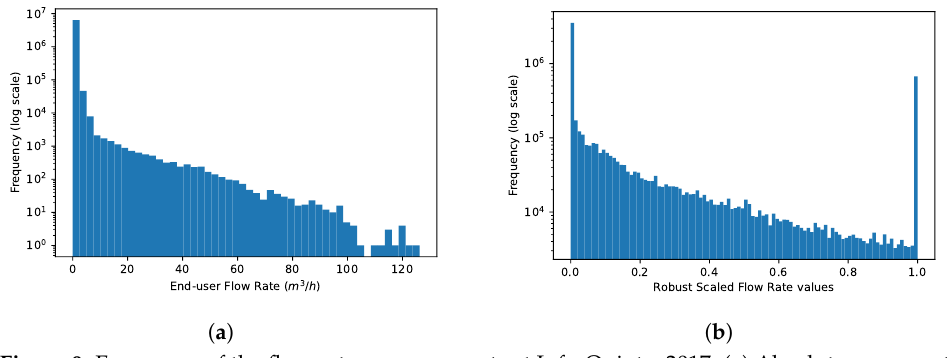
Figure 9. Frequency of the flow rate measurements at InfraQuinta, 2017. ( a ) Absolute consumption values. ( b ) Normalized consumption